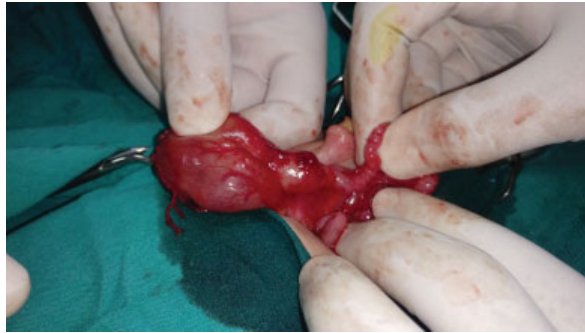
Fig. 2 Intraoperative double duodenal atresia with duodenal cyst in between.